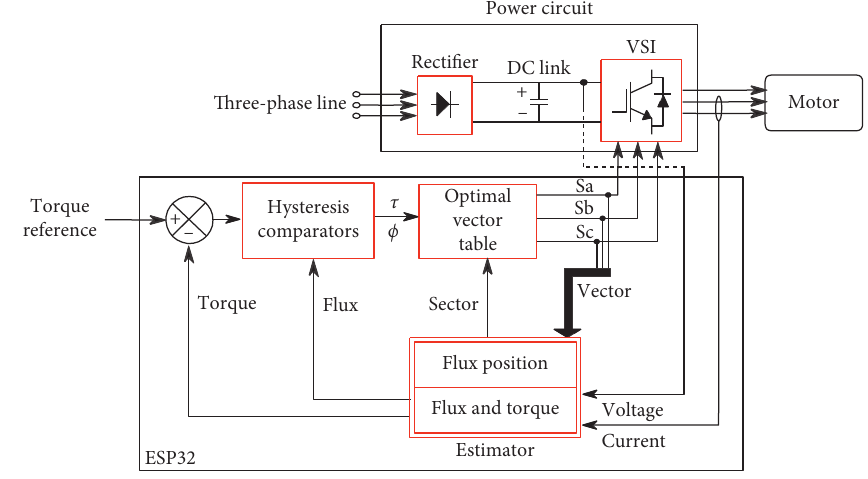
Figure 1: Block diagram for the classical DTC